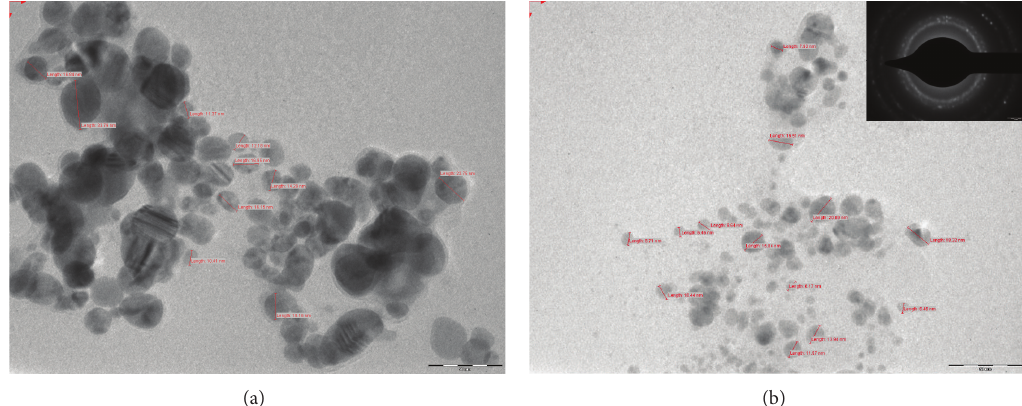
Figure 13: (a) TEM micrograph of SNPs synthesized using F. oxysporum without applying optimized conditions showed SNPs in range 10– 40nm (scale bar—50nm), (b) SNPs of size 10–20 nm synthesized by applying optimized condition (scale bar—50 nm) (inset: diffraction spot reveals the polycrystalline nature of